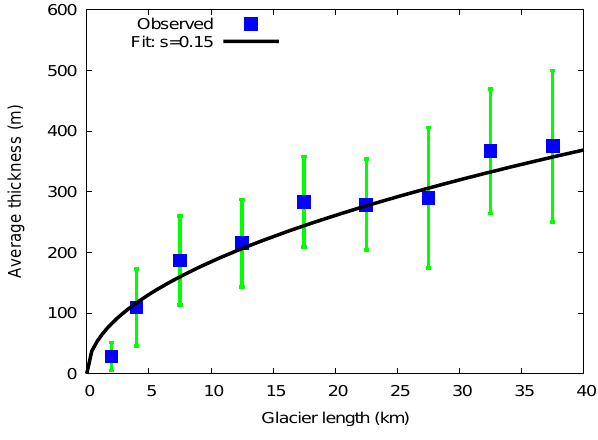
Fig. 10. Observed variation of mean thickness (filled squares), with error bars as function of L from WGI database (2009). Solid line represents the curve fit for a value of s of 0.15.